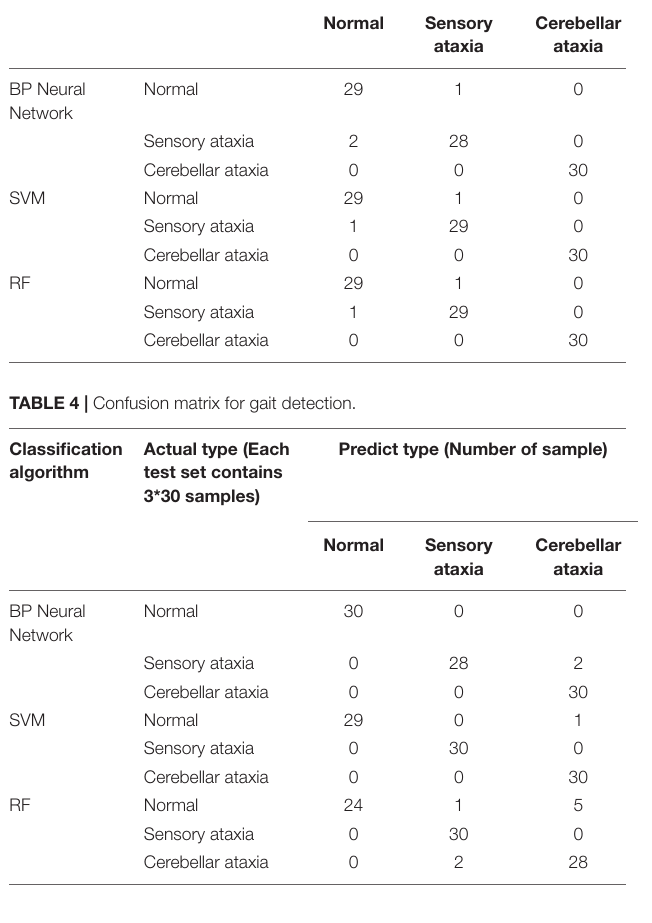
Table 4 , the source of error rate of RF algorithm is mainly used to identify the normal person between sensory ataxia and